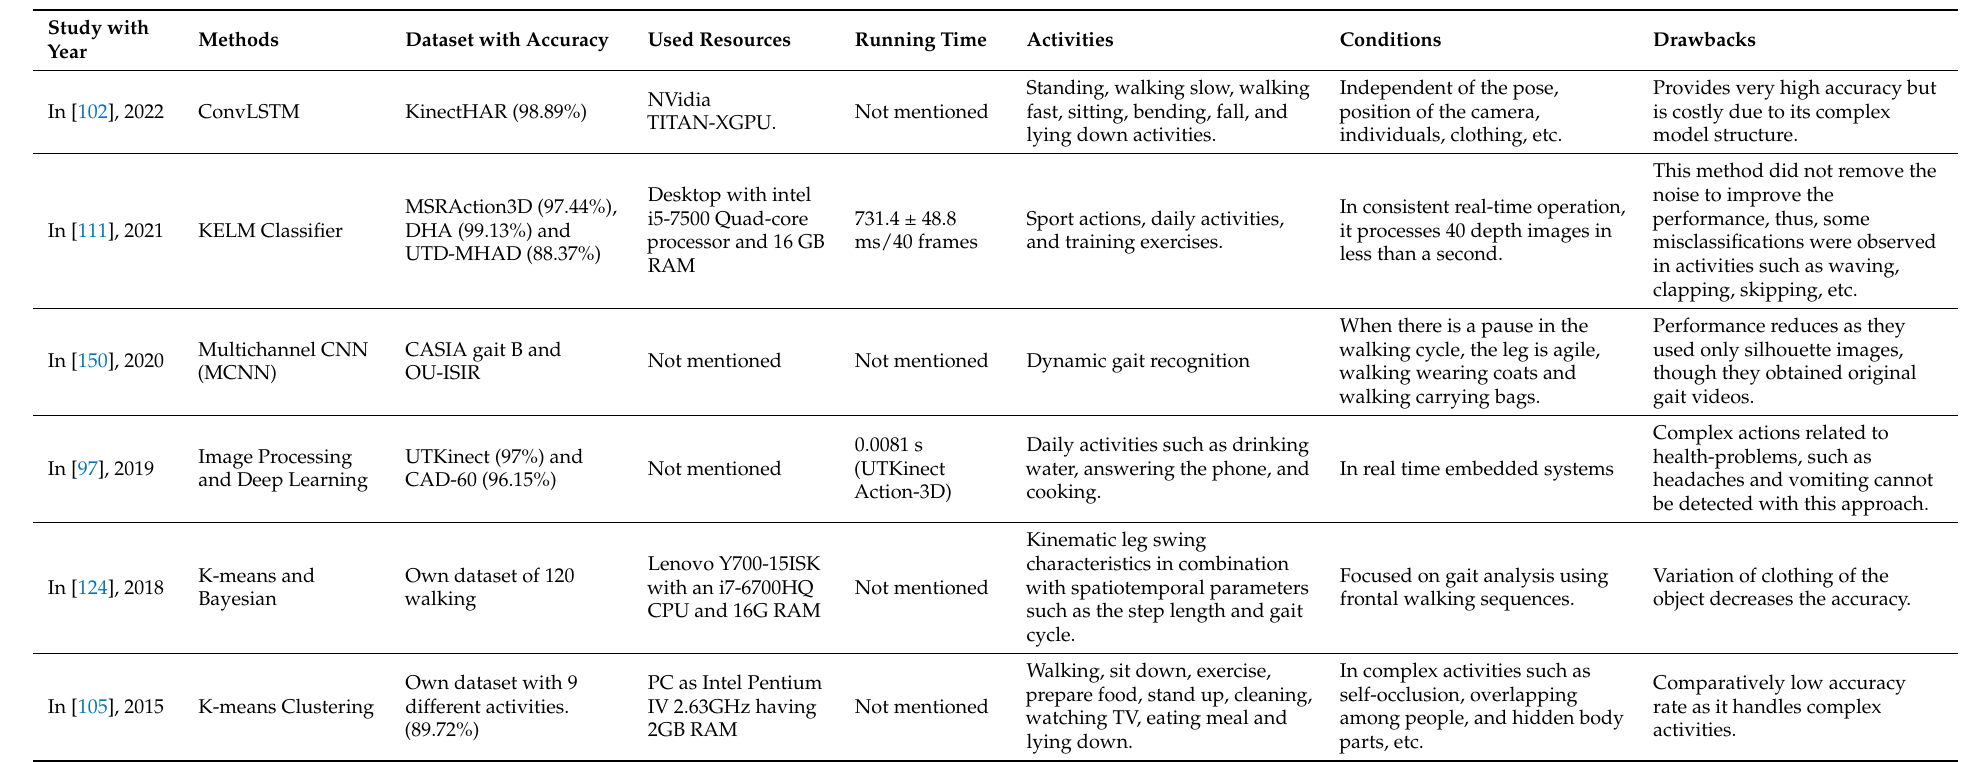
Table 6. Comparison of some Methods with activities and their